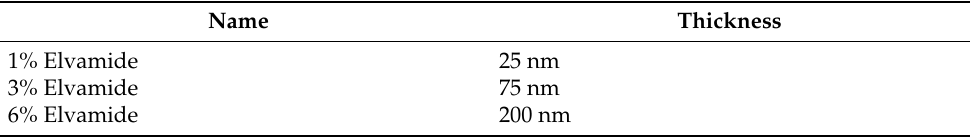
Table 1. Thickness of Elvamide coating layer before